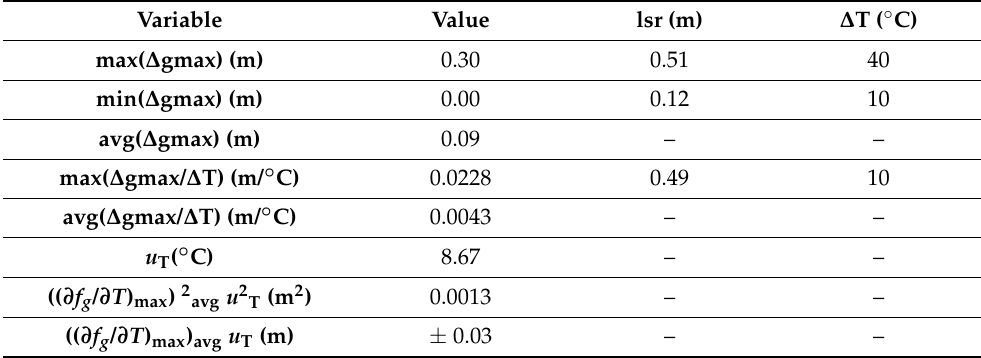
Table 1. Estimated contribution of the oil temperature to the combined measurement uncertainty of the non-iterative algorithm, in the first simulation.